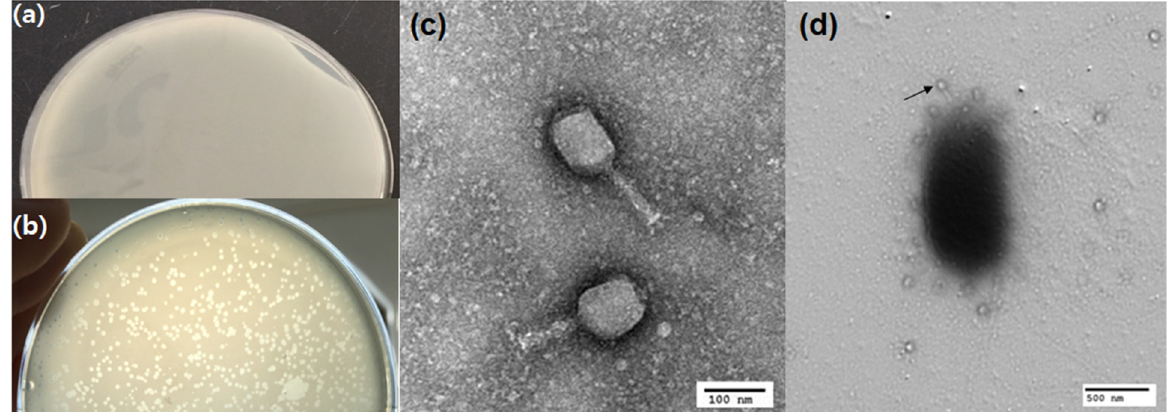
Figure 3. Double-layer agar plates and images of transmission electron microscope (TEM), ( a ) Control (no plaque), ( b ) plaque formation (phage infection), ( c ) TEM image of bacteriophage under 100 nm. ( d ) TEM image of phage–bacterial interaction under 500 nm. Arrow represents phages.